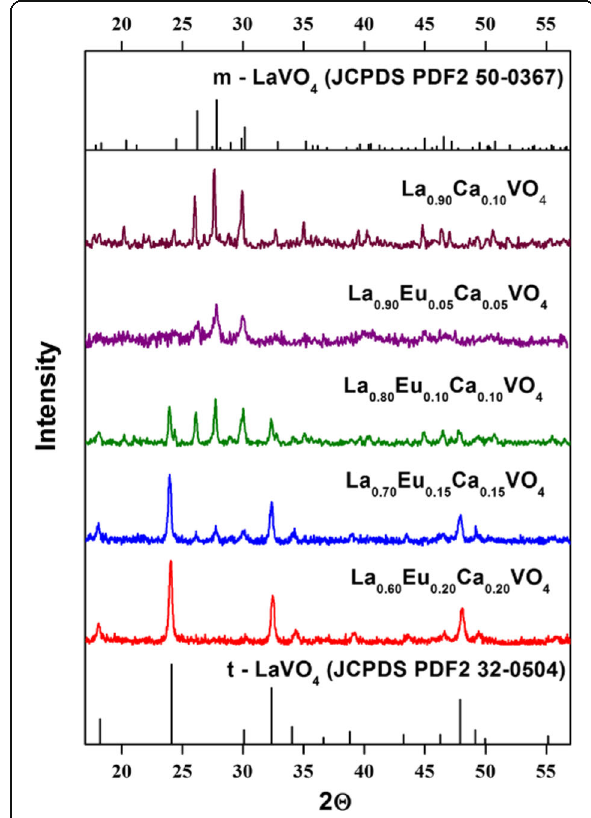
Fig. 2 X-ray diffraction patterns of the La 1 − x Ca x VO 4 and La 1 − x − y Eu y Ca x VO 4 (0 ≤ x , y 0.2)